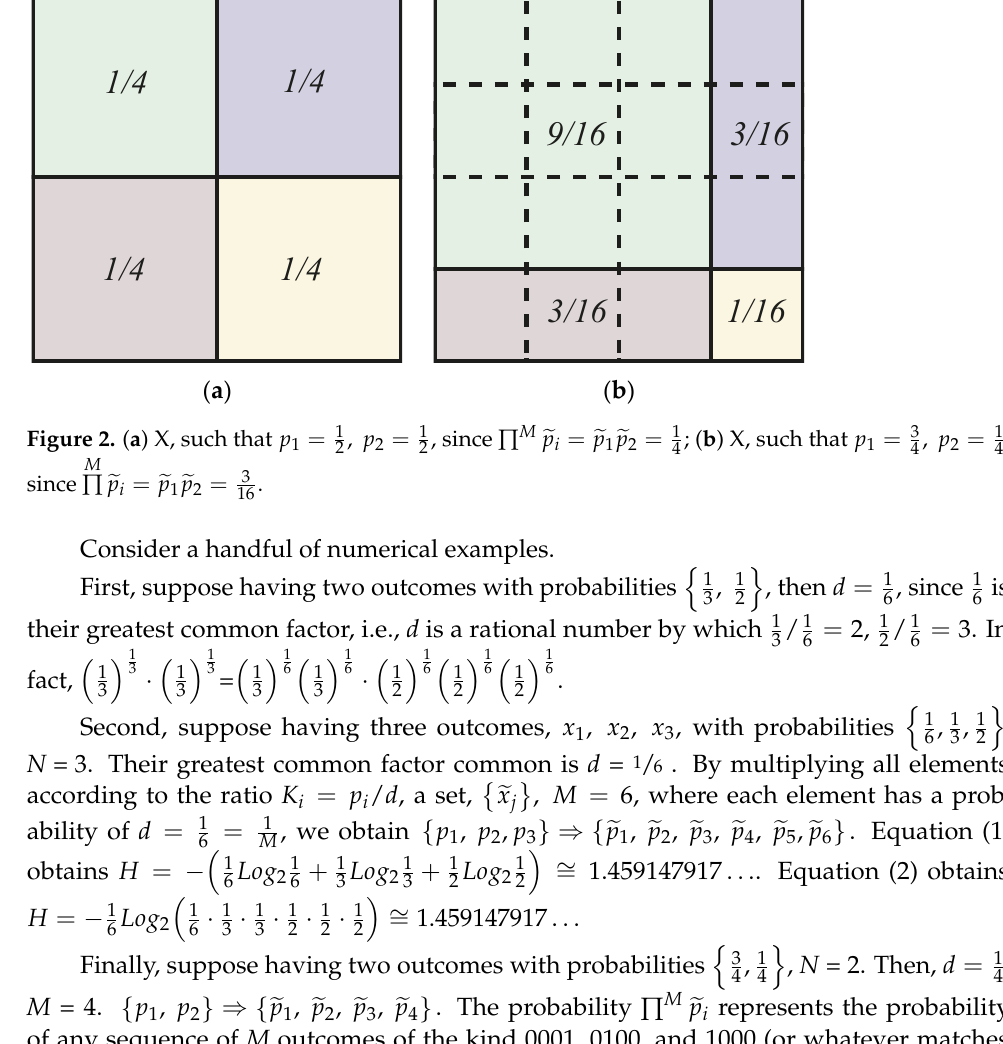
Figure 1. Each discrete set of probabilities 𝑝 𝑖 can be split into a larger set of equally probable events 𝑝̃ 𝑖 .